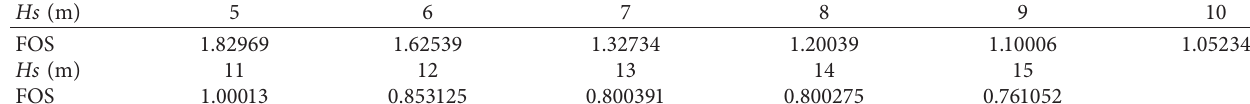
Table 5: Calculation results of deep foundation pit FOS under different Hs .